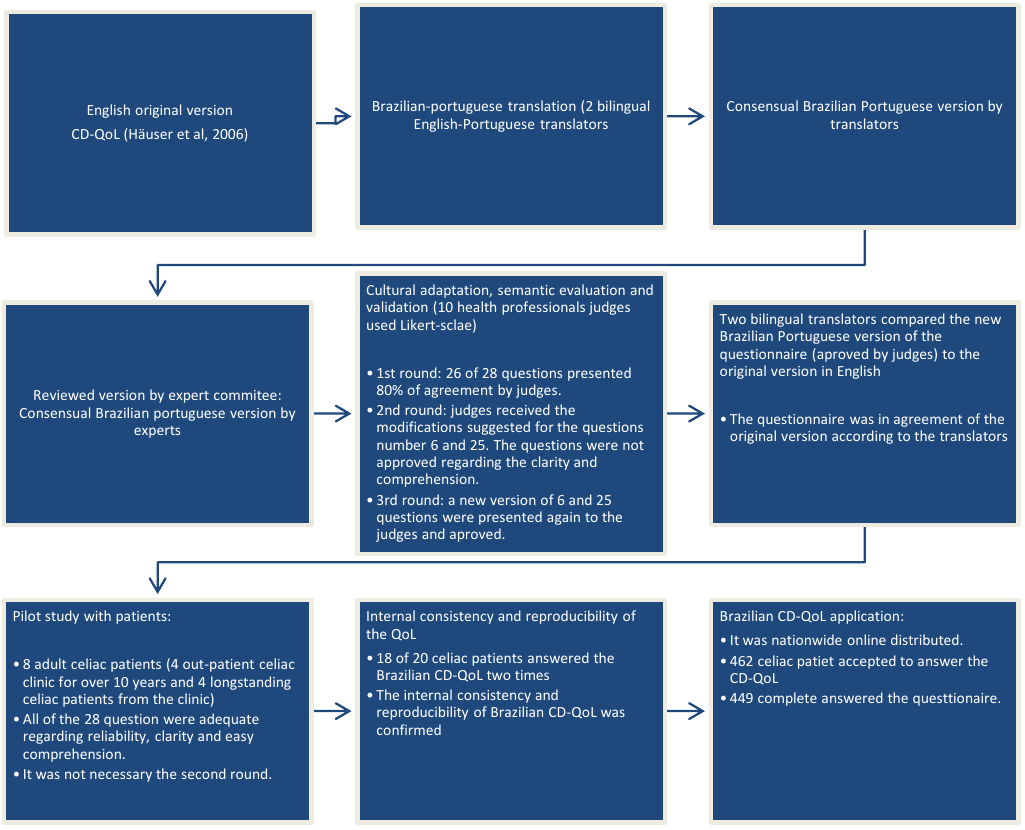
Figure 1. Process stages of the Brazilian celiac disease questionnaire of quality life (CD-QoL).